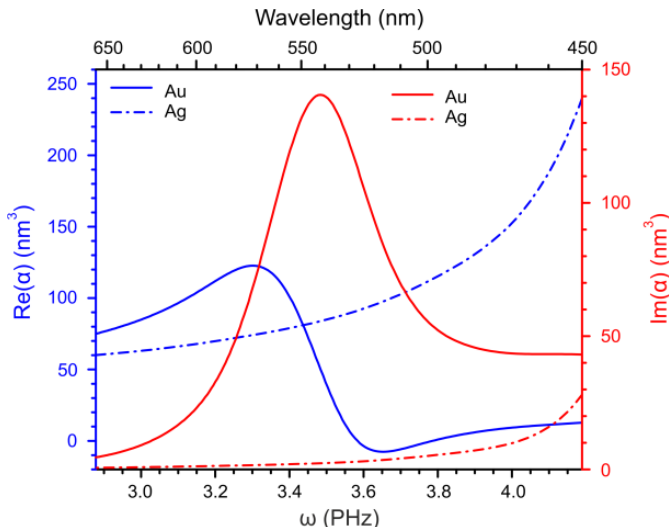
Figure 1. Frequency dependence of the effective polarizability of AuNP and AgNP of the radius 2.5 nm in the nematic host 5 CB